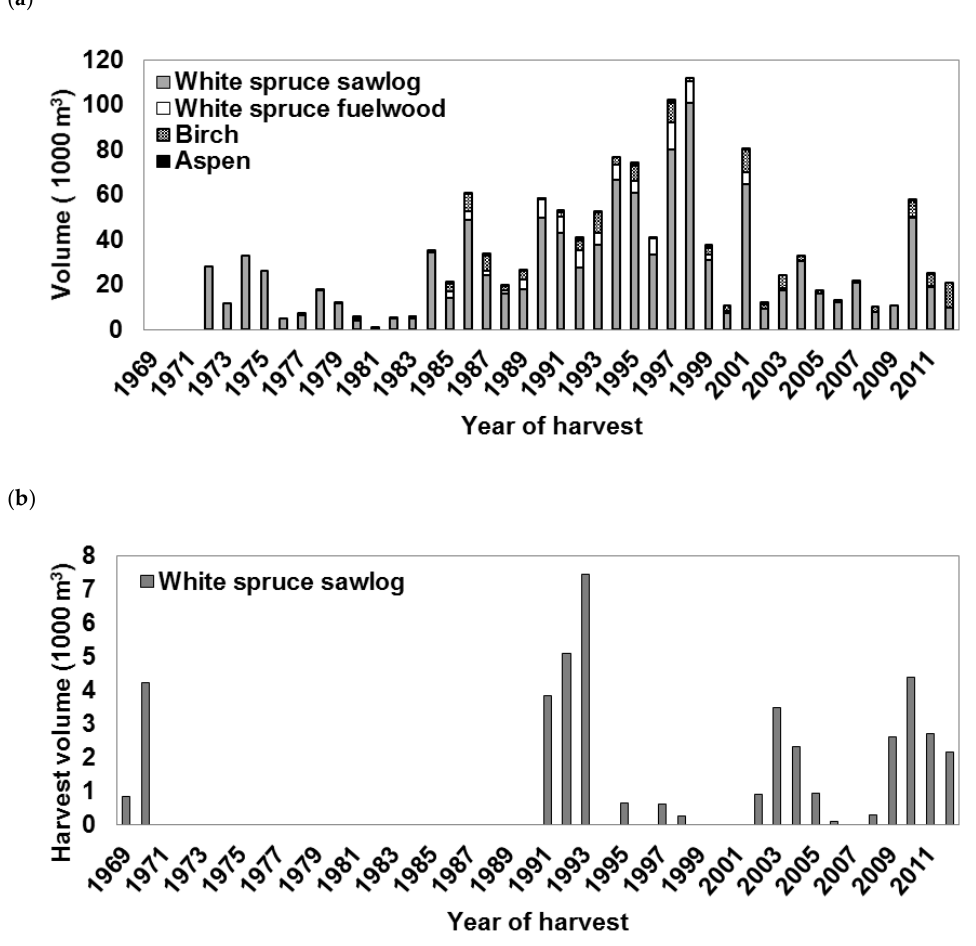
Figure 4. Annual volume harvested (1000 m 3 ) by species / product on ( a ) state forest lands from 1972 to 2012, and ( b ) other forest lands from 1969 to 2012. For other forest lands, the volumes were measured in board feet, which is not directly convertible to cubic meters. We simply multiplied the values in board feet by 0.00235974, which results in errors. The volume data are missing on both state forest lands (10% of area harvested) and other forest lands (20% of area harvested). On other forest lands, volume data are missing on units harvested in 1976 and 1981. On state forest lands, year of harvest is also missing for those units missing volume data.